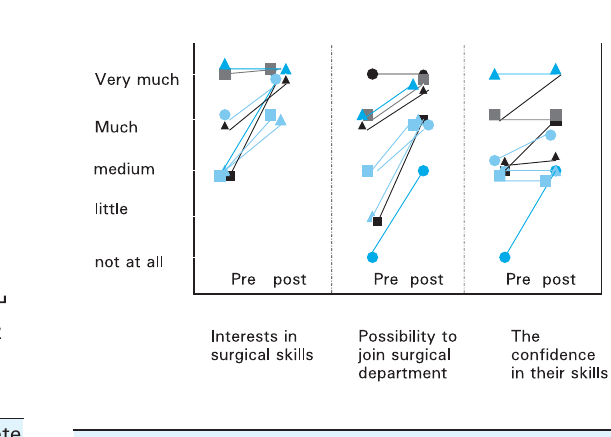
Figure 2. Results of questionnaire to the students